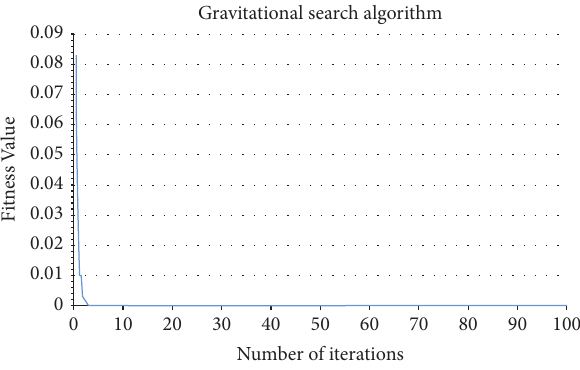
Figure 3: Convergence graph for Shell S36.